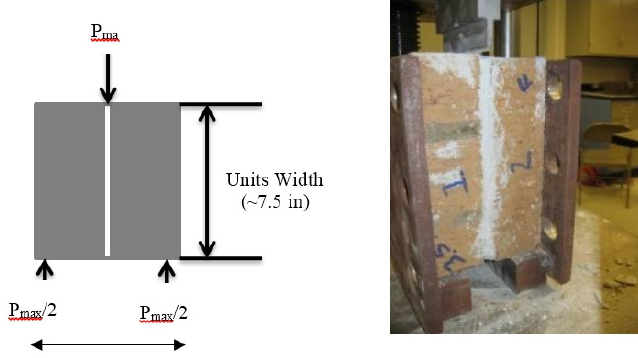
Figure 5. Shear bond strength test-setup.